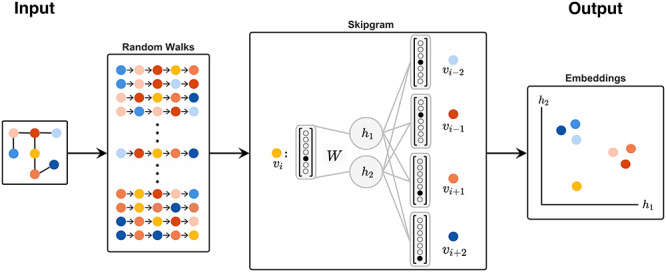
This shows the process of learning a simple graph embedding using DeepWalk. From an input graph, a fixed number of random walks are generated from each node with a predetermined length. The embeddings for each node are then learned using the Skipgram objective, where a node on the random walk is given as input to a single layer neural network. The input is compressed down to an \documentclass[12pt]{minimal}
\usepackage{amsmath}
\usepackage{wasysym}
\usepackage{amsfonts}
\usepackage{amssymb}
\usepackage{amsbsy}
\usepackage{upgreek}
\usepackage{mathrsfs}
\setlength{\oddsidemargin}{-69pt}
\begin{document}
}{}$d$\end{document}-dimensional representation (here, \documentclass[12pt]{minimal}
\usepackage{amsmath}
\usepackage{wasysym}
\usepackage{amsfonts}
\usepackage{amssymb}
\usepackage{amsbsy}
\usepackage{upgreek}
\usepackage{mathrsfs}
\setlength{\oddsidemargin}{-69pt}
\begin{document}
}{}$d=2$\end{document}) with an embedding matrix \documentclass[12pt]{minimal}
\usepackage{amsmath}
\usepackage{wasysym}
\usepackage{amsfonts}
\usepackage{amssymb}
\usepackage{amsbsy}
\usepackage{upgreek}
\usepackage{mathrsfs}
\setlength{\oddsidemargin}{-69pt}
\begin{document}
}{}$W \in \mathbb{R}^{\mid V \mid \times d}$\end{document}, and then used to predict which nodes surround it on the walk. That is, a node \documentclass[12pt]{minimal}
\usepackage{amsmath}
\usepackage{wasysym}
\usepackage{amsfonts}
\usepackage{amssymb}
\usepackage{amsbsy}
\usepackage{upgreek}
\usepackage{mathrsfs}
\setlength{\oddsidemargin}{-69pt}
\begin{document}
}{}$v_i$\end{document} is used to predict the surrounding nodes on the walk within a given context window (here, size two): \documentclass[12pt]{minimal}
\usepackage{amsmath}
\usepackage{wasysym}
\usepackage{amsfonts}
\usepackage{amssymb}
\usepackage{amsbsy}
\usepackage{upgreek}
\usepackage{mathrsfs}
\setlength{\oddsidemargin}{-69pt}
\begin{document}
}{}$v_{i-2}, v_{i-1}, v_{i+1}$\end{document} and \documentclass[12pt]{minimal}
\usepackage{amsmath}
\usepackage{wasysym}
\usepackage{amsfonts}
\usepackage{amssymb}
\usepackage{amsbsy}
\usepackage{upgreek}
\usepackage{mathrsfs}
\setlength{\oddsidemargin}{-69pt}
\begin{document}
}{}$v_{i+2}$\end{document}. After training, this lower dimensional representation for each node, which can be easily retrieved from \documentclass[12pt]{minimal}
\usepackage{amsmath}
\usepackage{wasysym}
\usepackage{amsfonts}
\usepackage{amssymb}
\usepackage{amsbsy}
\usepackage{upgreek}
\usepackage{mathrsfs}
\setlength{\oddsidemargin}{-69pt}
\begin{document}
}{}$W$\end{document}, is then used as the embedding for each node. Note that DeepWalk chooses the next node in the random walk uniformly at random, and therefore can return to previous nodes in the walk, whereas node2vec introduces a parameter to control the probability of doing so.